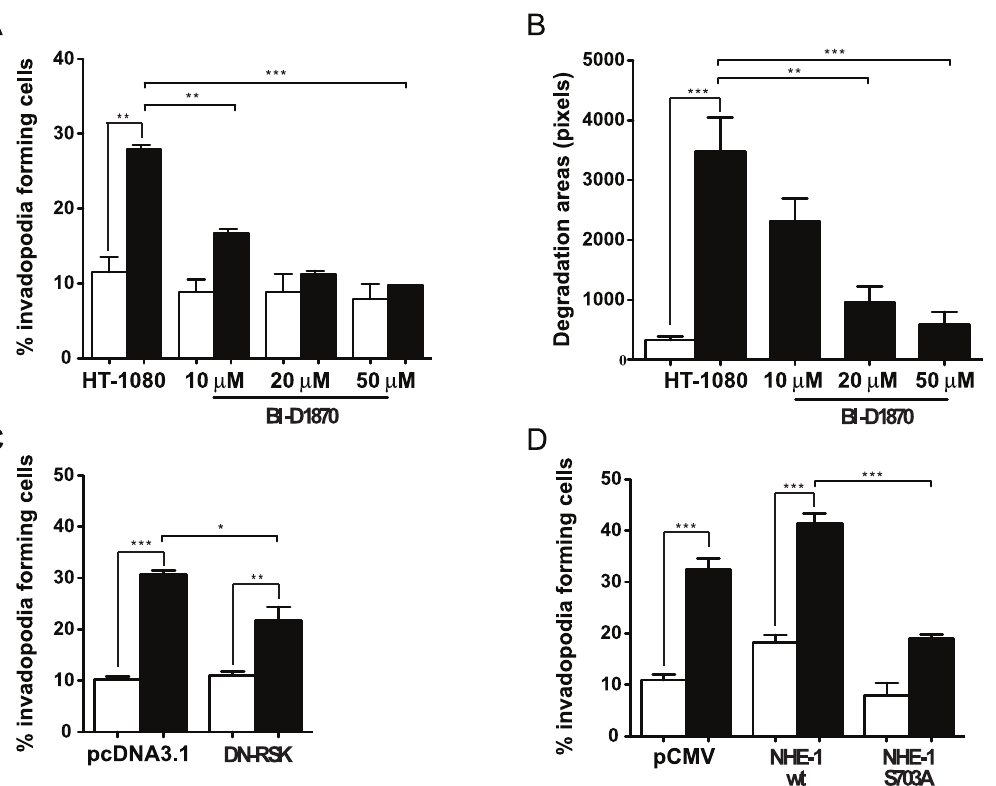
Figure 6. Hypoxia-induced RSK activation promotes invadopodia formation. HT-1080 cells were cultured under normoxia (empty bars) or hypoxia (filled bars). (A) Percentage of cells producing invadopodia cultured in presence or absence of BI-D1870 (n=3). (B) Quantification of invadopodia-associated matrix degradation was performed (n=2). (C–D) Percentage of HT-1080 cells producing invadopodia in cells (C) transfected with DN-RSK (n=3), or (D) transfected with NHE-1 WT or S703A (n=3). Columns represent the mean 6 SEM indicated by the horizontal bars. The asterisks correspond to, * p , 0.01; ** p , 0.001; *** p , 0.0001.